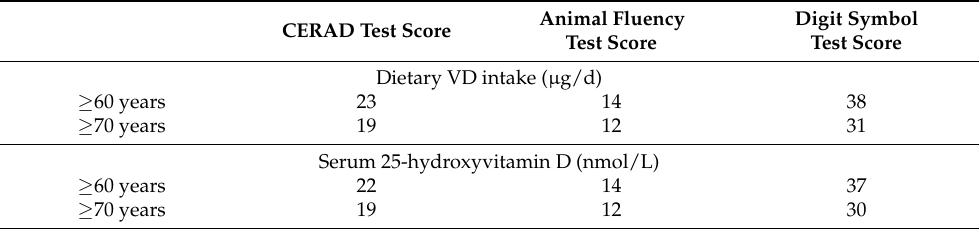
Figure 1. Flow chart of the screening process for the selection of eligible dietary VD intake and serum 25(OH)D participants. Table 1. The cognitive performance cutoff points of CERAD test, Animal Fluency test, and DSST score adjusted according to age ( ≥ 60 years and ≥ 70